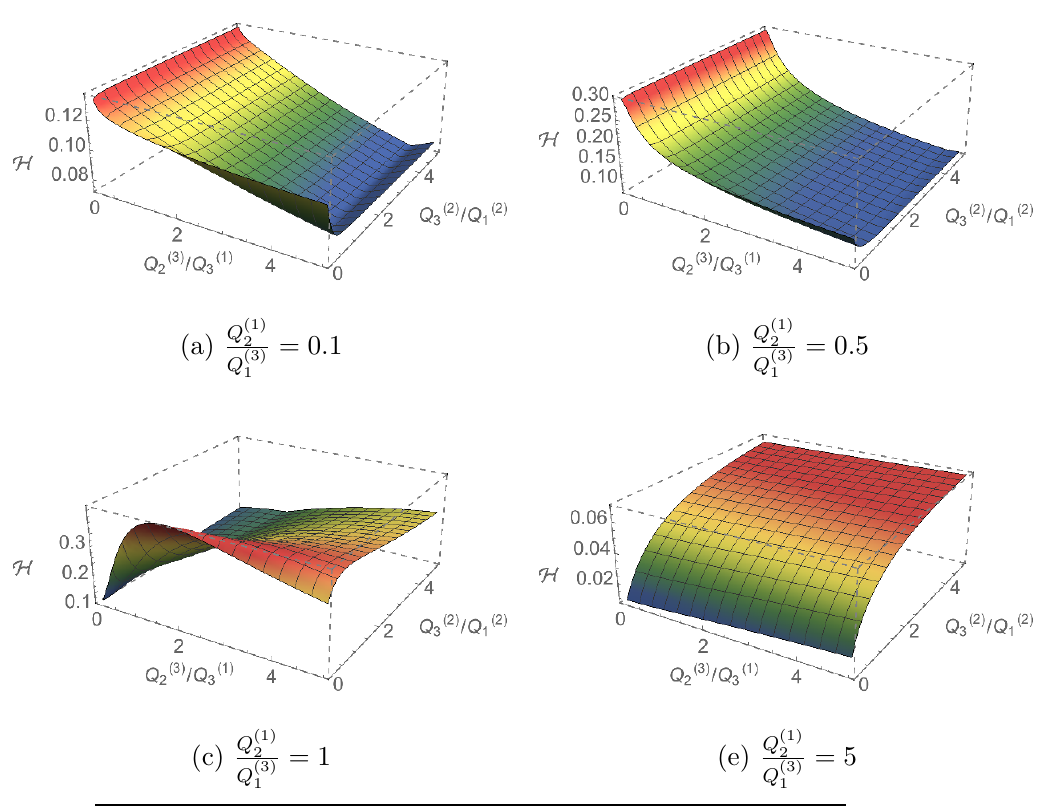
Figure 3 . The entropy parameter H as a function of the charge ratios with q , q 1 , q 2 , k 1 , (cid:0) k 2 and k 3 equal to